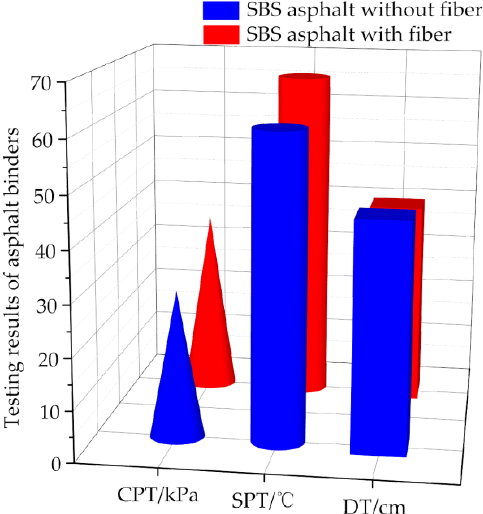
Figure 7. Uniaxial static compression creep test in this paper.